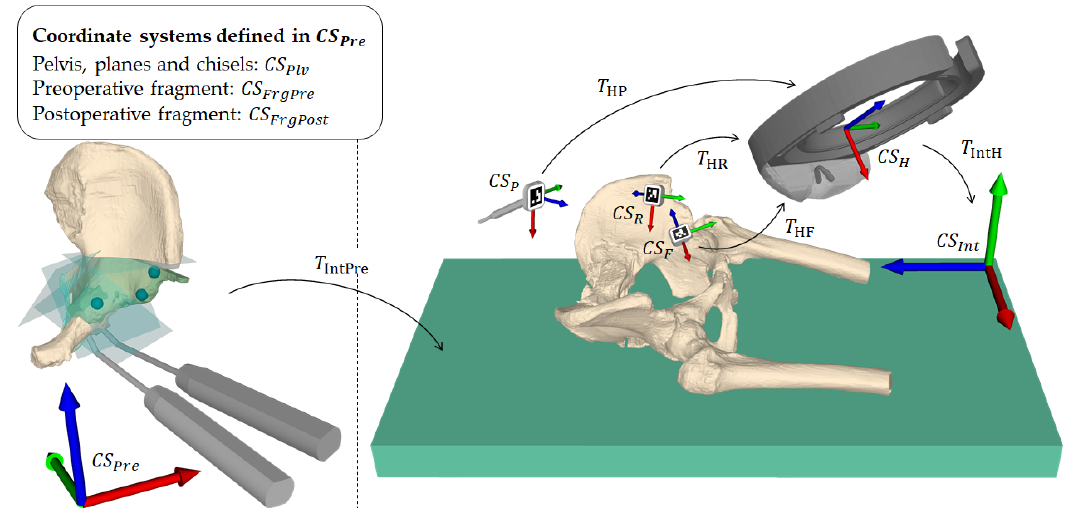
Figure 6. Overview of coordinate systems and transformations. A transformation from coordinate system A to coordinate system B is denoted as T BA . CS Pre is the preoperative planning space defined by the computed tomography coordinate system and CS Int is the intraoperative space defined by the HoloLens on application startup. CS Plv is the pose of the planning in CS Pre . CS FrgPre and CS FrgPost are the pre- and planned postoperative fragment poses in CS Pre . T IntPre is the final registration. CS P , CS R and CS F are the local coordinate systems of the pointing device, pelvic marker and fragment marker, respectively. CS H is the local coordinate system of the HoloLens, defined by its built-in marker-less inside-out tracking